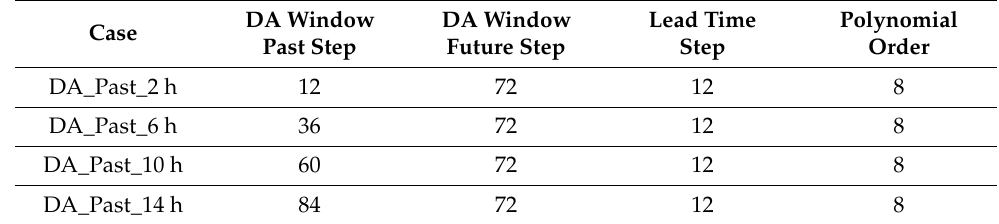
Table 3. The conditions for DA experiment 2-1: varying the past DA window.